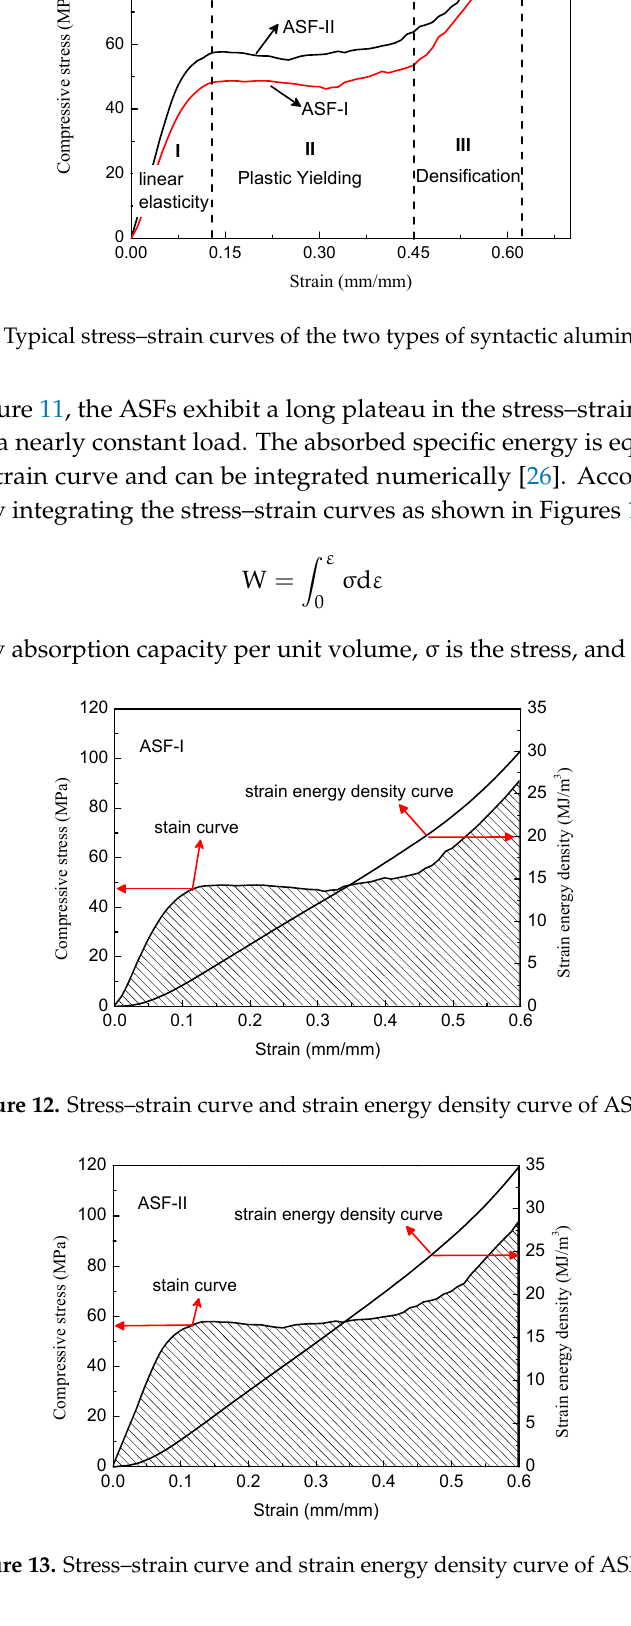
Figure 13. Stress–strain curve and strain energy density curve of ASF-II.